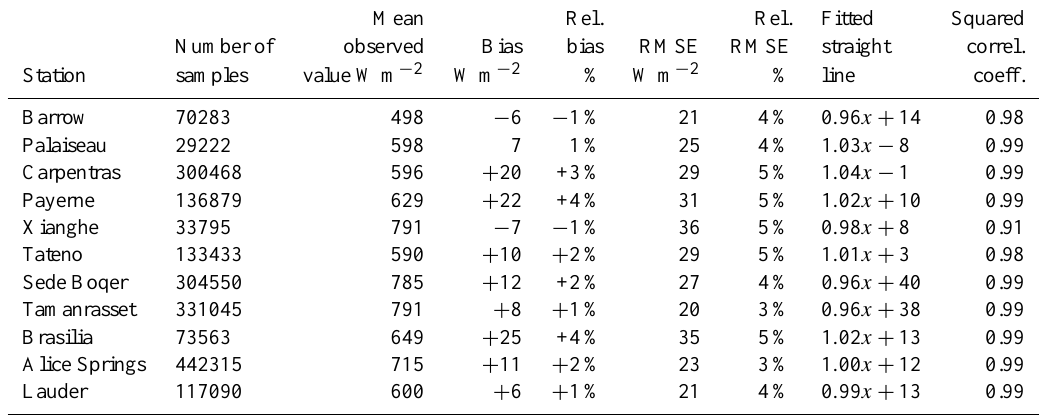
Table 2. Comparison between clear-sky global irradiances measured by BSRN and estimated by McClear. Mean Rel. Rel. Fitted Squared Number of observed Bias bias RMSE RMSE straight correl. Station samples coeff.